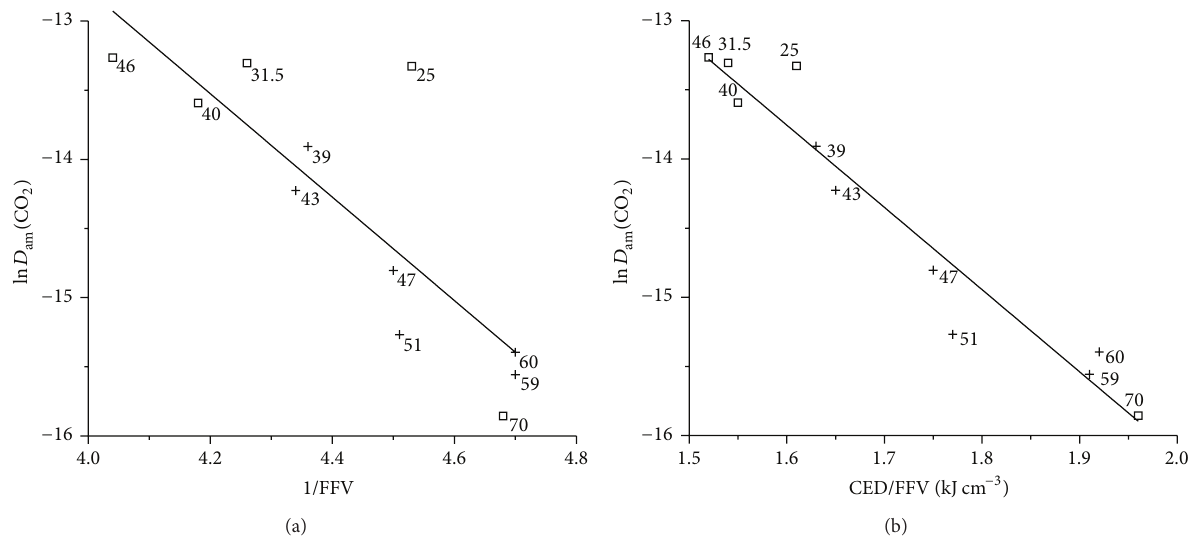
Figure 4: Correlation of the CO 2 diffusion coefficients with (a) 1/FFV and (b) CED/FFV for both pure EVA copolymers ( ◻ ) and their blends (+). Numbers next to the points indicate vinyl acetate content in a given material. Straight lines represent linear regression of the experimental data.